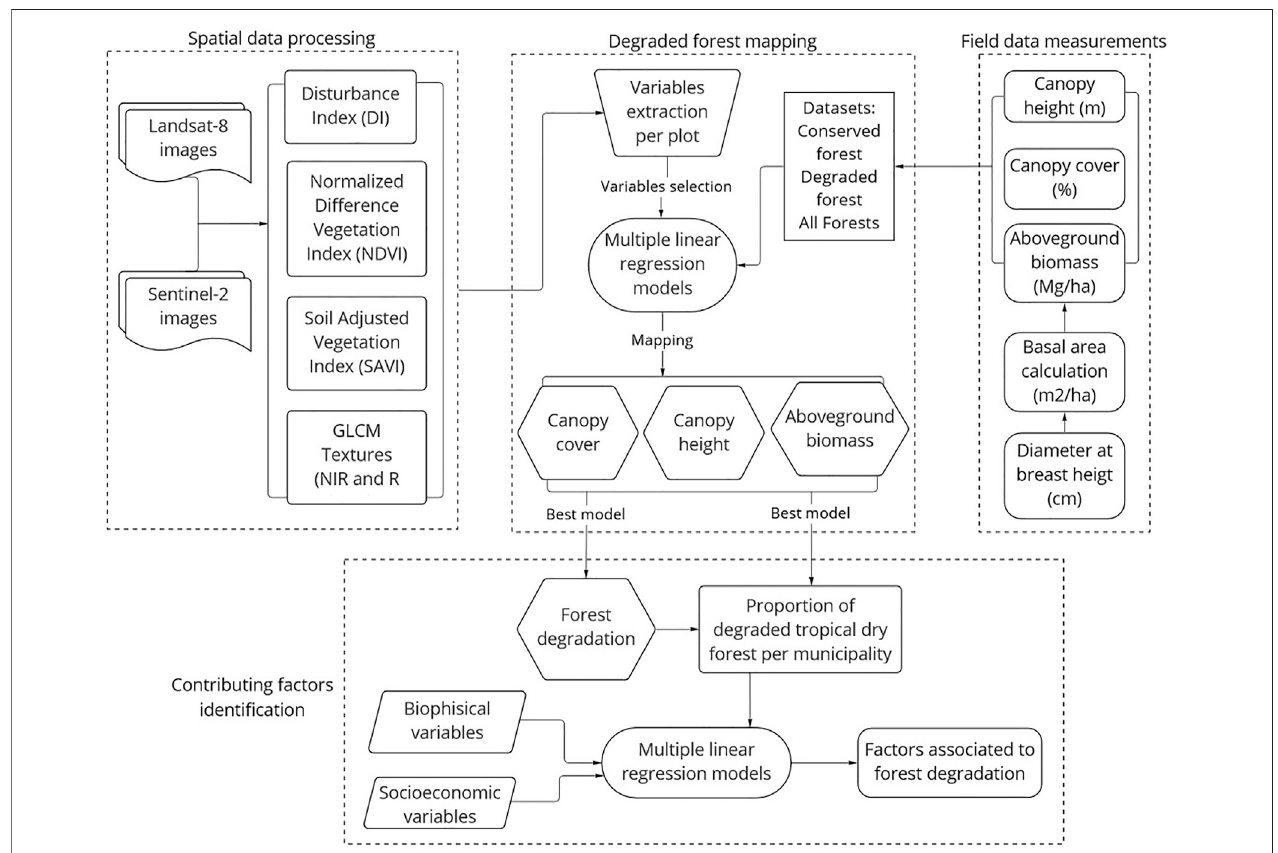
FIGURE 2 | Diagram of the general